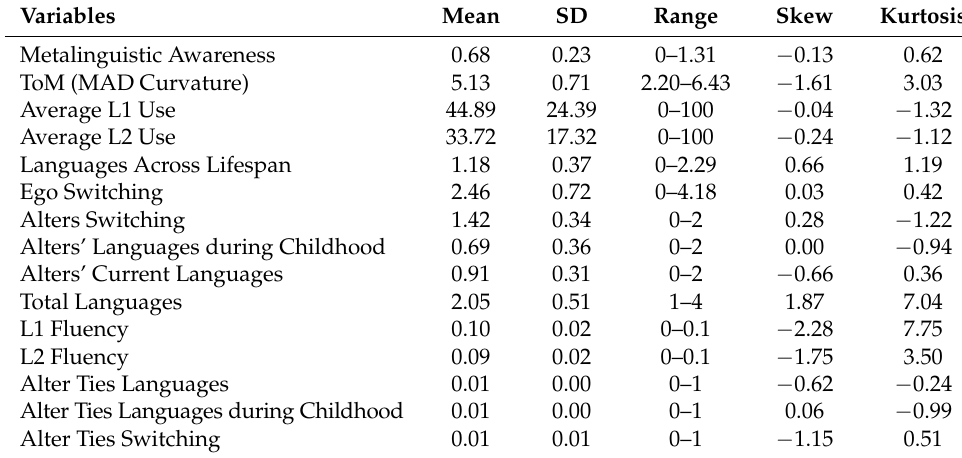
Table 2. Descriptive statistics ( N = 89).